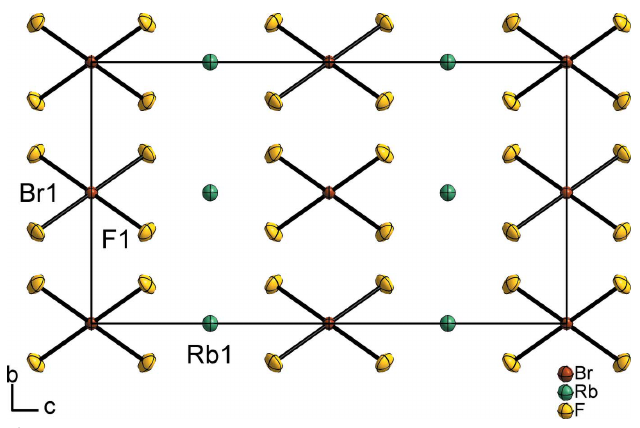
Figure 2 The crystal structure of the title compound in a projection along the a axis. Displacement ellipsoids are shown at the 70% probability level.